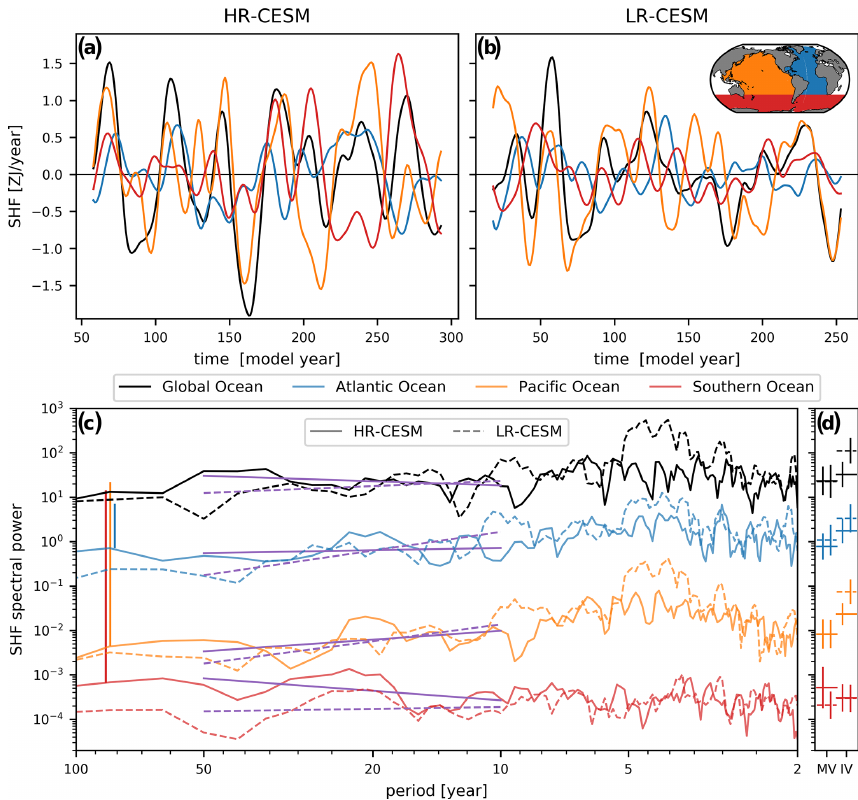
Figure 5. Time series for the 13-year low-pass-filtered surface heat fluxes (SHFs) into the global (black; equals thick solid line of Fig. 1), Atlantic (blue), Pacific (orange), and Southern (red) oceans for the HR- (a) and LR-CESM (b) simulations. The inset global map defines the three major ocean basins. Panel (c) shows the multi-taper spectral estimates of the unfiltered but quadratically detrended time series. The spectral slopes in the multidecadal variability band (MV; 10–50 years) are shown as purple lines. The spectral power means of the MV and interannual (IV; 2–10 years) bands are shown in panel (d) . The estimated standard deviations are shown as error bars shifted left (right) of the center for HR-CESM (LR-CESM). For visual clarity, the spectra were separated vertically by multiplying them by constant factors; these shifts are indicated by vertical lines in (c)